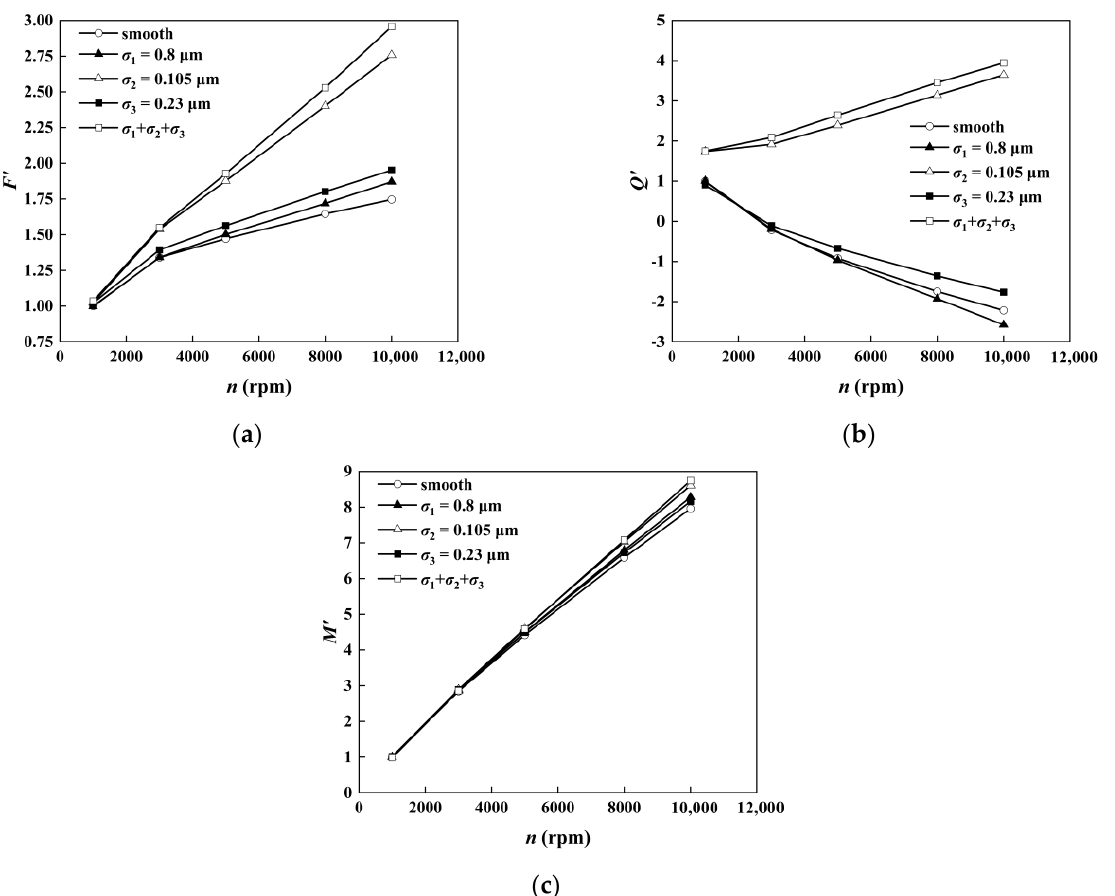
Figure 20. Comparison of sealing performance under different surface roughness conditions: ( a ) comparison of the opening force, ( b ) comparison of the leakage rate, ( c ) comparison of the friction torque.